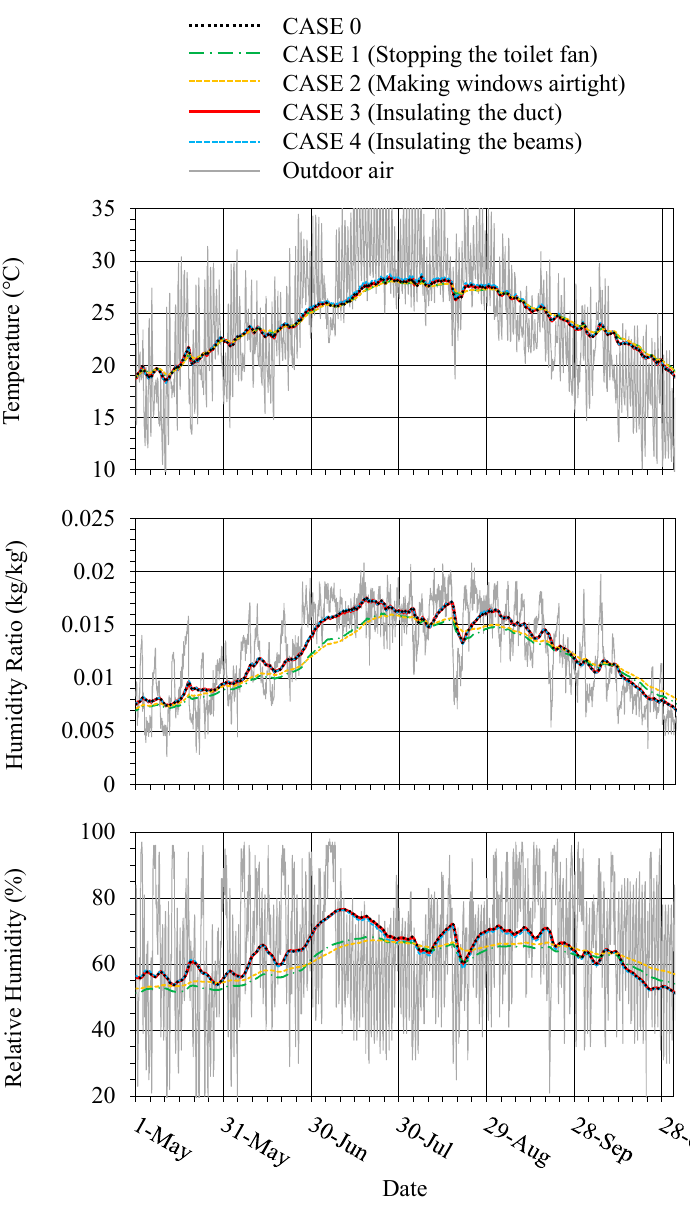
Figure 11. Temperature, humidity ratio, and RH in the storage room in each CASE.